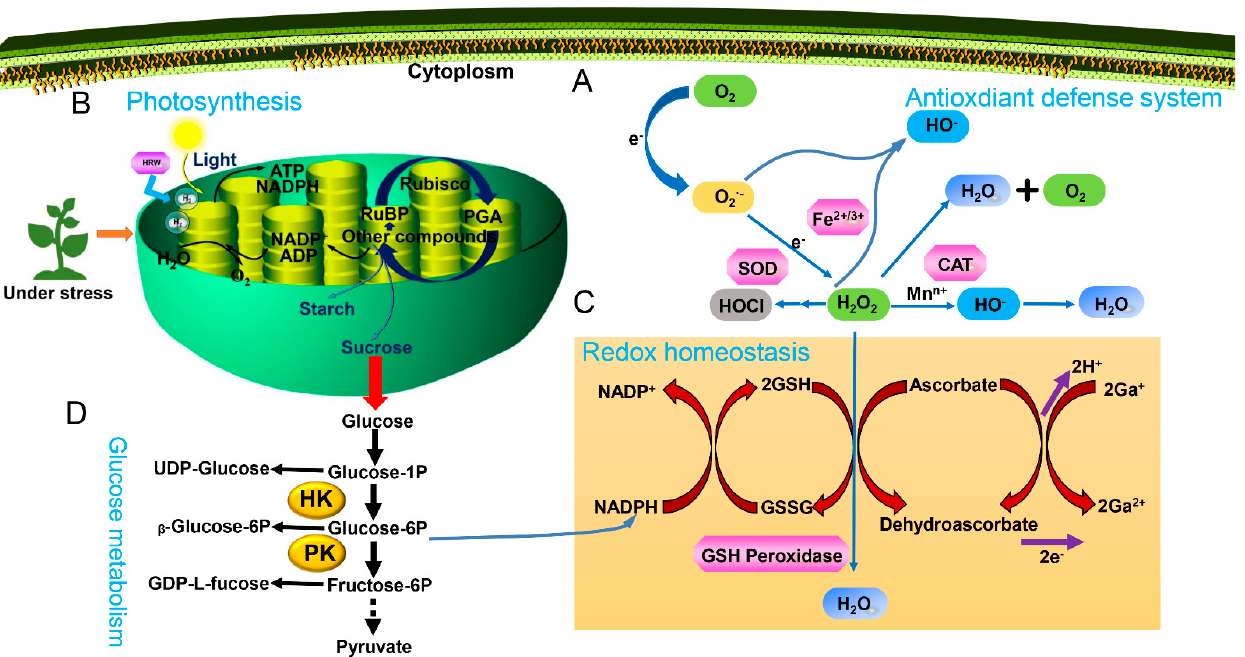
Figure 2. The regulatory mechanism of H 2 -medicated abiotic stress. ( A ), Antioxidant defense system. H 2 could regulate the antioxidant system by increasing the activities of antioxidant-related en- zymes and decreasing ROS accumulation and lipid peroxidation to relieve environmental stresses in plants. ( B ), Photosynthesis, H 2 could relieve abiotic stresses due to photosynthesis. ( C ), Redox homeostasis. H 2 could also regulate abiotic stresses via re-establishing redox homeostasis. ( D ), Glu- cose metabolism. Glucose metabolism is also involved in the regulation of abiotic stresses.